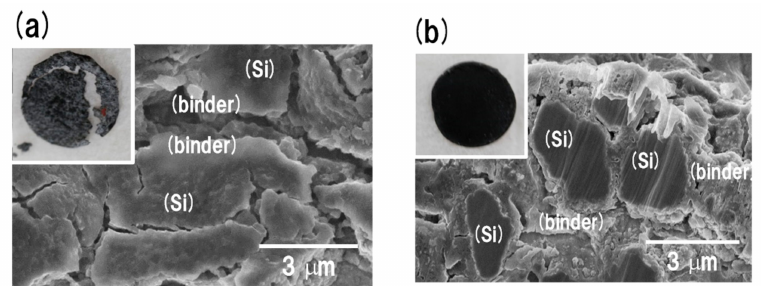
Figure 9. Overviews (inset in each scanning electron microscopy (SEM) views) and cross-sectional SEM views of anode electrodes with the composites of Si powder, Ketjenblack (KB) and binder (( a ) PVDF, ( b ) PI) after 100th cycle. The dark area in each SEM image indicates Si active materials.